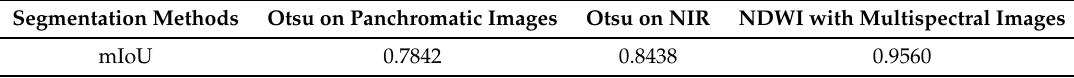
Table 3. Comparison of the segmentation performance of the NDWI and Otsu-based methods.